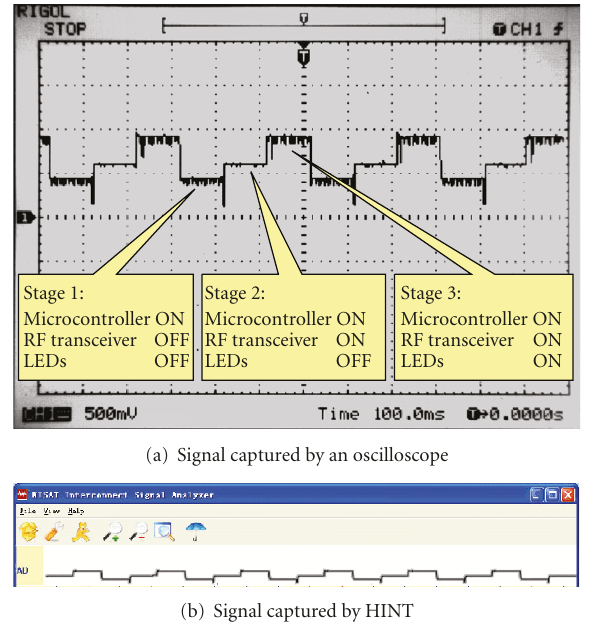
Figure 18: Comparison of analog signal acquisition.